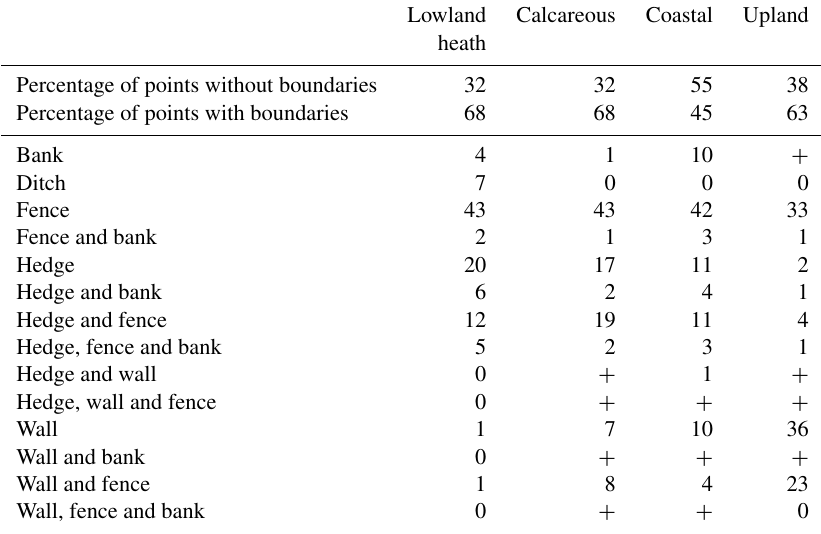
Table 8. Summary of boundaries by landscape type as a proportion of the total ( + denotes present at < 1%).